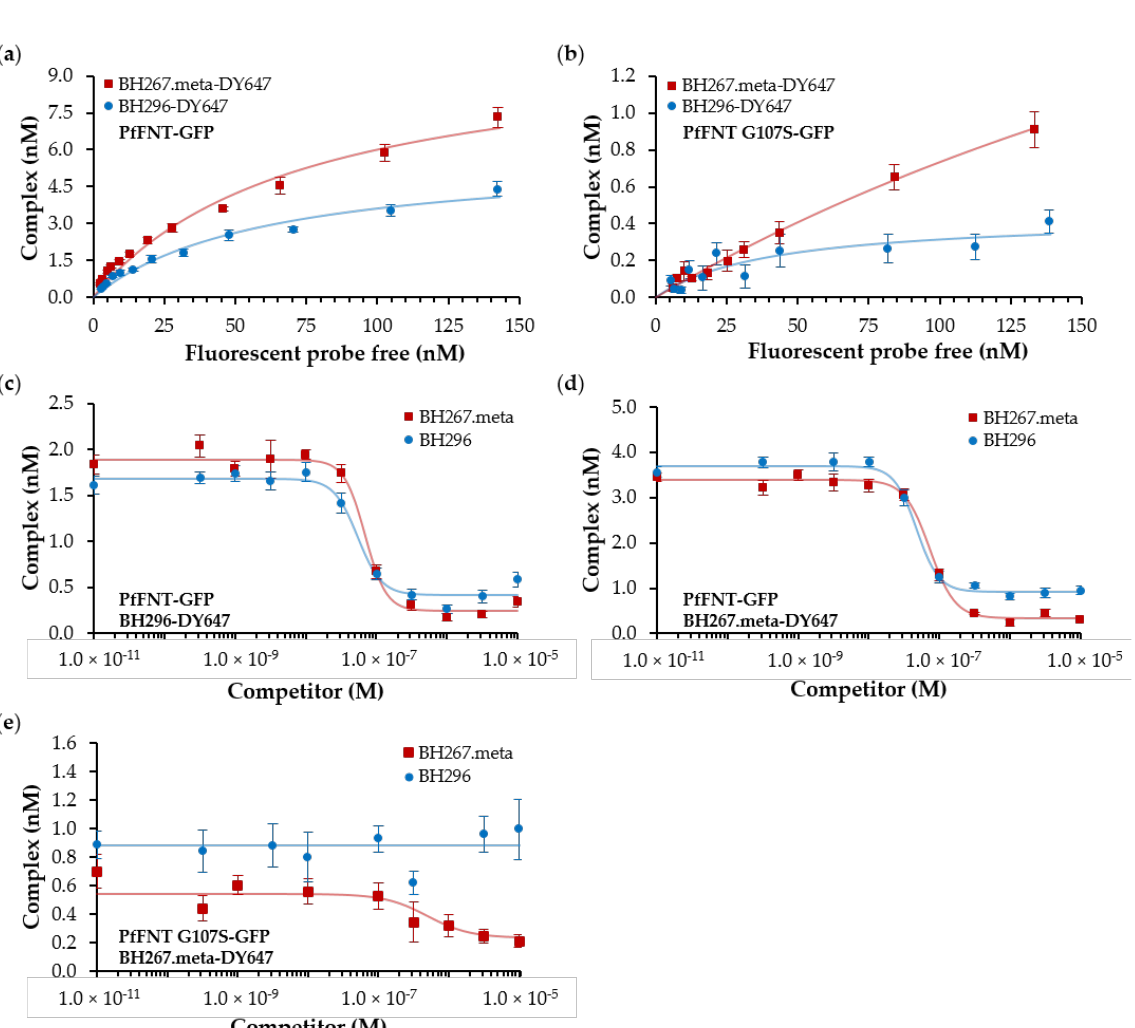
Figure 4. Affinity determination of BH296, BH267.meta to PfFNT and PfFNT G107S, and equilibrium saturation binding of BH296 and BH267.meta to PfFNT and PfFNT G107S. ( a ) BH296-DY647 and BH267.meta-DY647 bound with similar affinity to PfFNT (67 nM and 72 nM, respectively), but binding to BH296-DY647 was saturated with only 50% of the target involved in interactions. BH267.meta bound to 100% of the GFP-fusions of wildtype PfFNT. ( b ) Saturation binding assays of BH296-DY647 to mutant PfFNT-GFP indicated no affinity above background caused by fluorescence cross talk, but BH267.meta-DY647 bound with a K D of 405 nM. ( c ) Membrane preparations containing 10 nM of PfFNT-GFP were incubated with 70 nM BH296-DY647, and associated complexes competed with free compounds BH267.meta and BH296 to assess their K i values. In the absence of a competitor, 1.5 nM of complex was formed, and both compounds displaced the tracer completely with a K i of 48 and 66 nM, respectively. ( d ) Using BH267.meta-DY647 as a tracer, both compounds displaced the total of 3 nM complexes with K i values of 47 and 56 nM. ( e ) Membrane preparations containing GFP fusions of mutant PfFNT G107S were mixed with 150 nM of the labeled BH267.meta tracer and competed with BH267.meta and BH296. Only BH267.meta displaced the tracer with a K i of 417 nM, whereas BH296, even at concentrations of 10 µM, did not compete in the interaction.